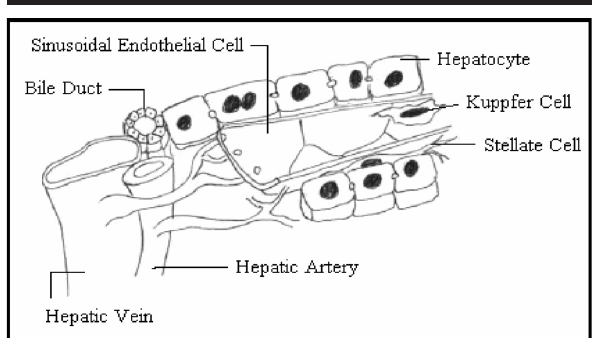
FIGURE 3 - Perisinusoidal